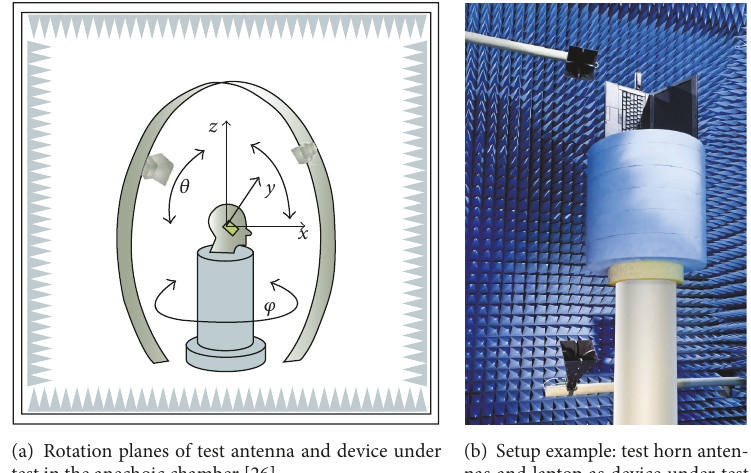
Figure 5: Test system setup, theoretical and practical.